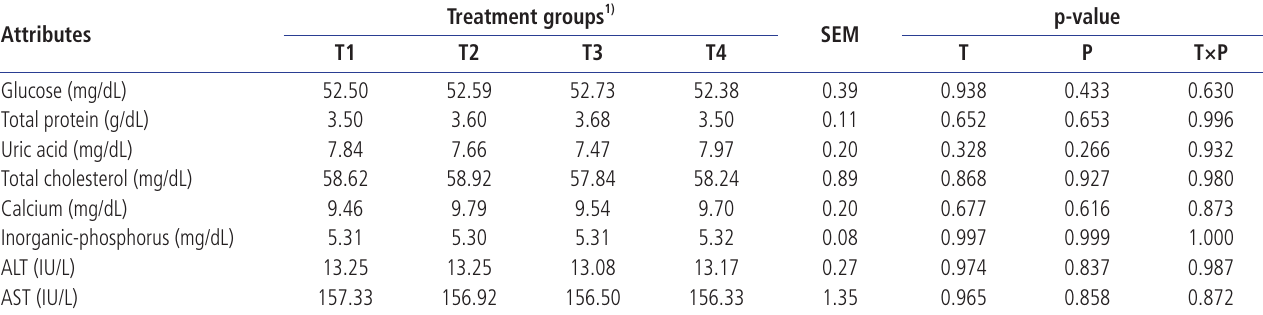
Treatment groups 1)